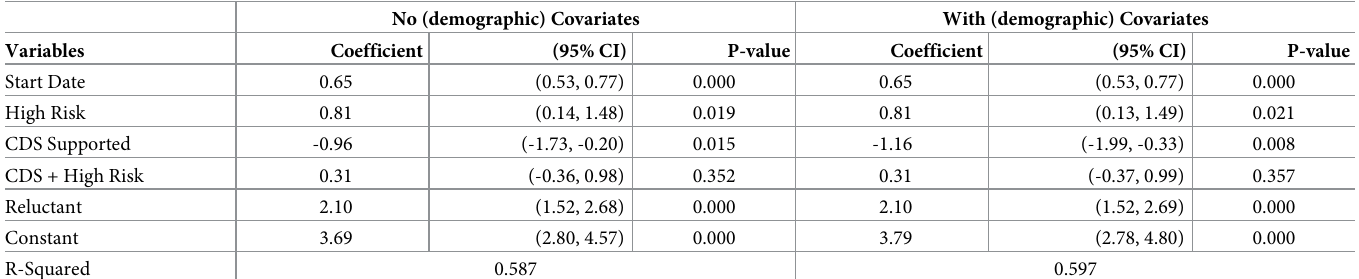
Table 1. Linear regression (OLS) models of length of stay on decision-support availability, degree of readmission risk, and patient preference for